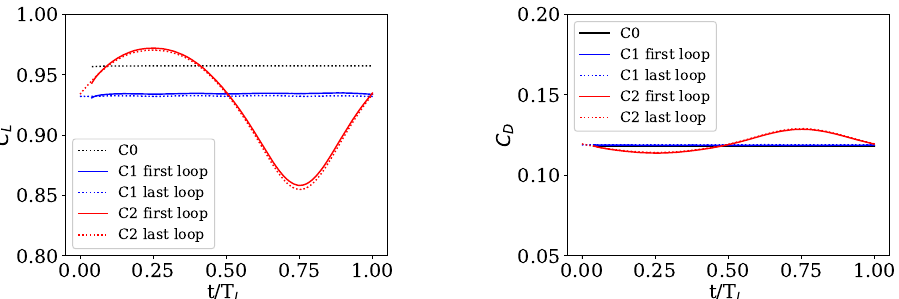
Figure 12. ( left ) Lift and ( right ) drag coefficients versus time for (C0) level flight, (C1) crosswind flight with uniform inflow and (C2) crosswind flight with logarithmic